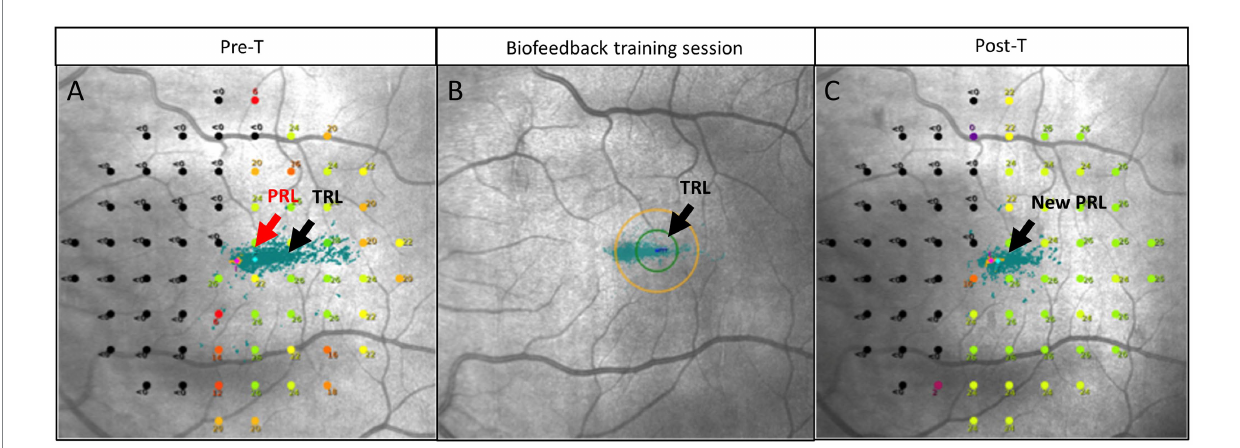
FIGURE 1 Principle of biofeedback training (BT). (A) Pre-BT microperimetry C10-2, left eye. Each green point is an attempt of fixation. Preferred retinal locus (PRL) center is located initially at a 22 dB point, there is splitting of fixation. A trained retinal locus (TRL) was selected toward the seeing retina on a 25 dB retinal point. (B) Biofeedback training session as reported by MAIA microperimeter: green dots—fixation attempts. Original PRL (on the left) has more fixation attempts (green dot), while BT training moves fixation points toward the TRL (on the right). (C) The center of the new PRL area is located at a 25 dB retinal point. A temporal relocation occurred, and splitting of the fixation was mitigated. The microperimetry shown in C is a 2-year follow up for patient 2.